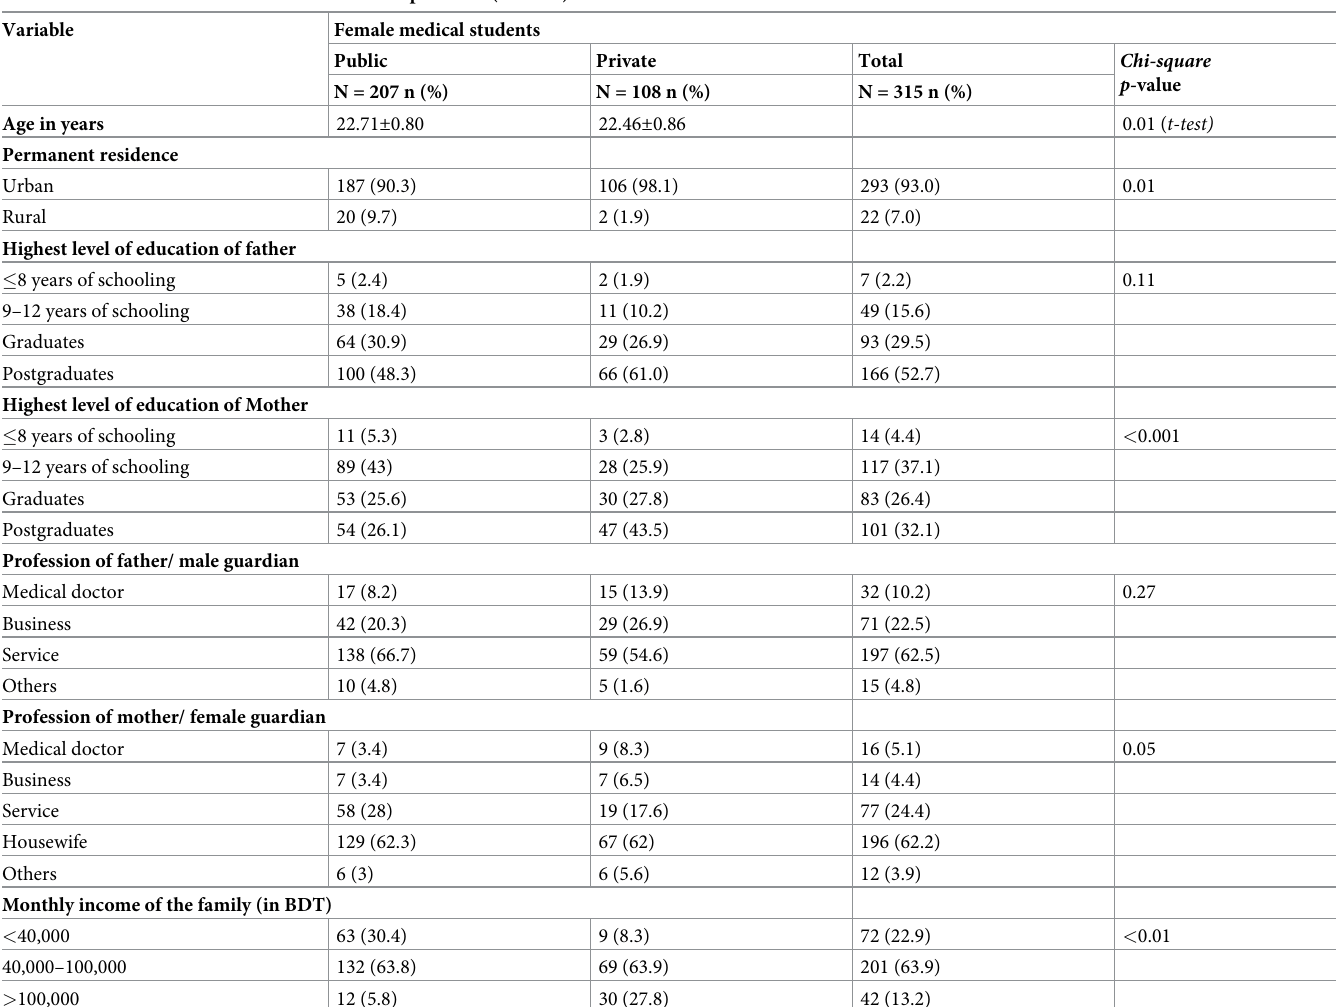
Table 3. Socio economic characteristics of the respondents (N =